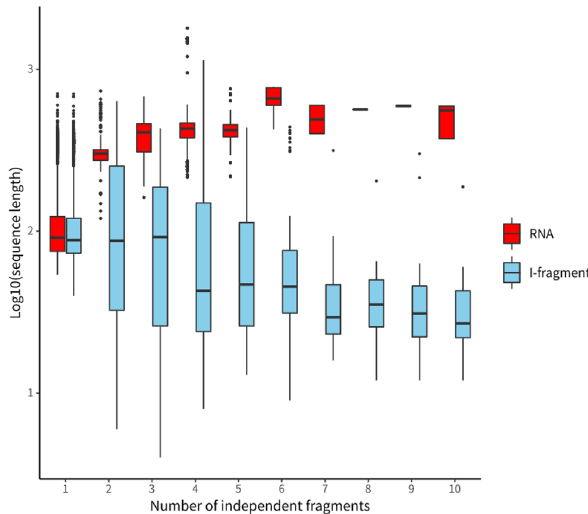
Figure 7. Contrast in length distribution of whole RNAs and i-fragments.